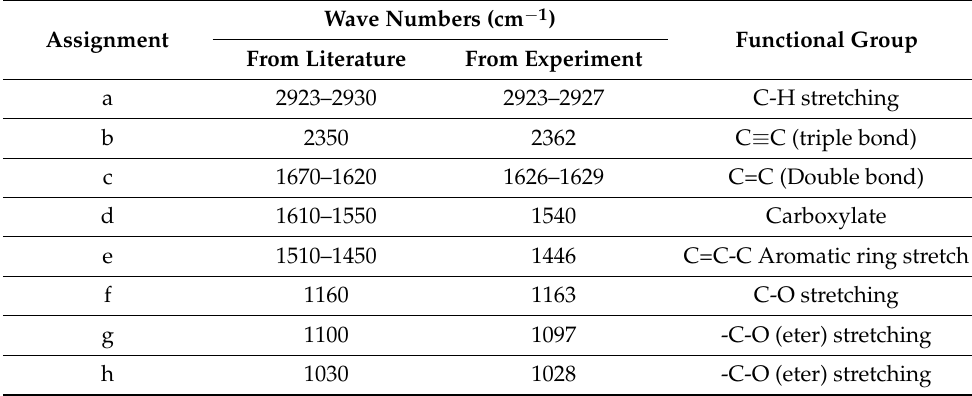
Figure 10. FTIR spectra of buffalo leather samples 7 to 9. Table 4. Functional groups and their quantified